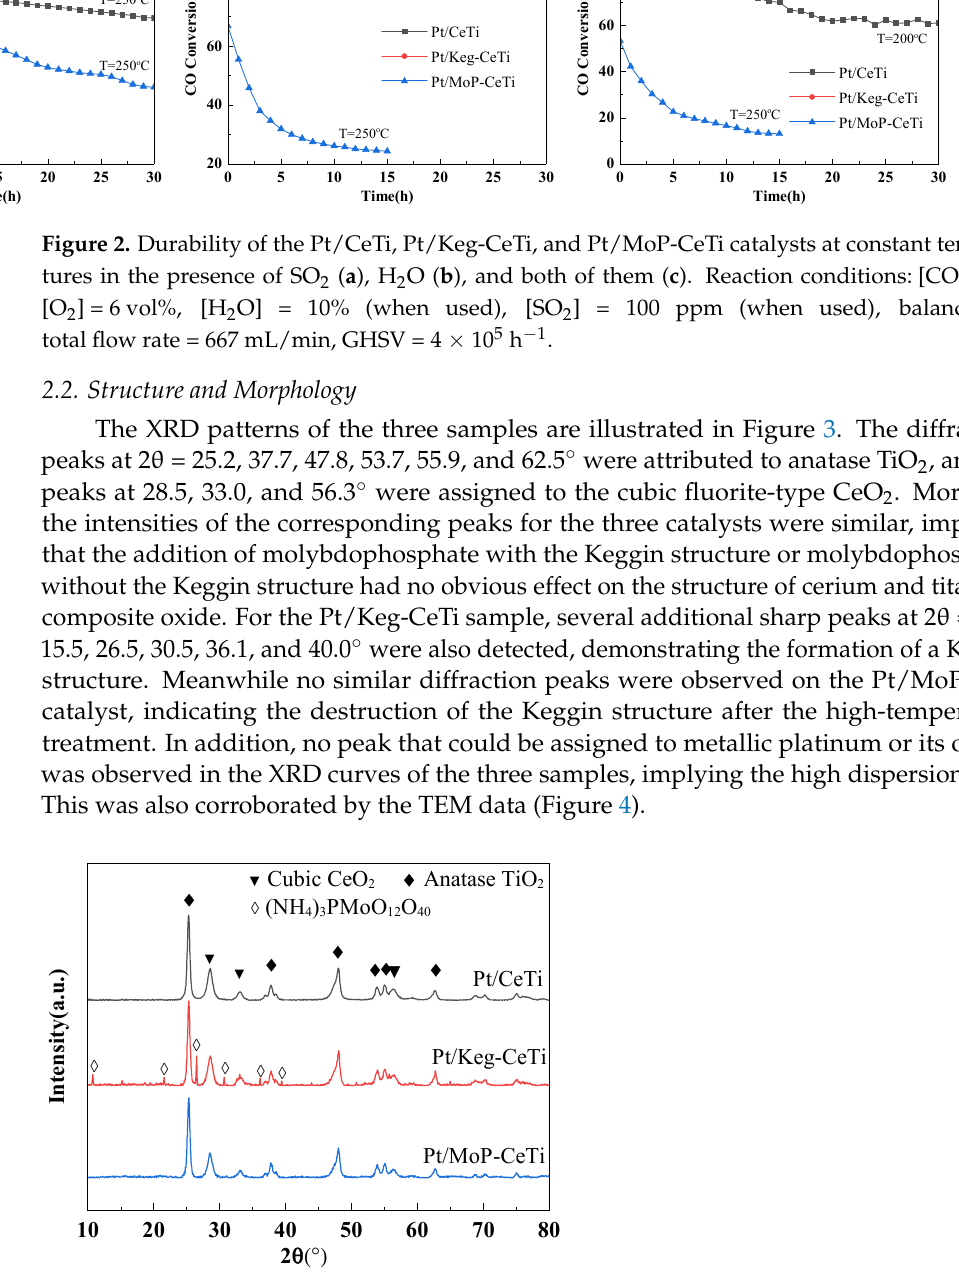
Figure 3. X-ray diffraction patterns of the Pt/CeTi, Pt/Keg-CeTi, and Pt/MoP-CeTi catalysts. The porosities of the Pt/CeTi, Pt/Keg-CeTi, and Pt/MoP-CeTi catalysts were charac- terized by N 2 adsorption-desorption isotherms (Figure S1). The three samples all showed typical type II isotherms and type H3 hysteresis loops in a high relative pressure range of P/P 0 > 0.5, indicating the existence of stacking channels and the sorption behavior of mes- opores. Meanwhile, there was no obvious saturated adsorption platform in the low-pres- sure range, revealing that there were few micropores on the catalyst surface (Figure S1). This was in agreement with their relatively low specific surface area (41–63 m 2 /g) (Table 1). The pore volumes of Pt/Keg-CeTi and Pt/MoP-CeTi were comparatively smaller than that of Pt/CeTi possibly due to the blocking of partial pores of CeTi by the molybdophos- phate, and the pore diameter of Pt/Keg-CeTi was slightly larger than those of the two others, which might be related to the difference in particles’ size. Table 1. Textural and structural properties of the catalyst samples. Samples